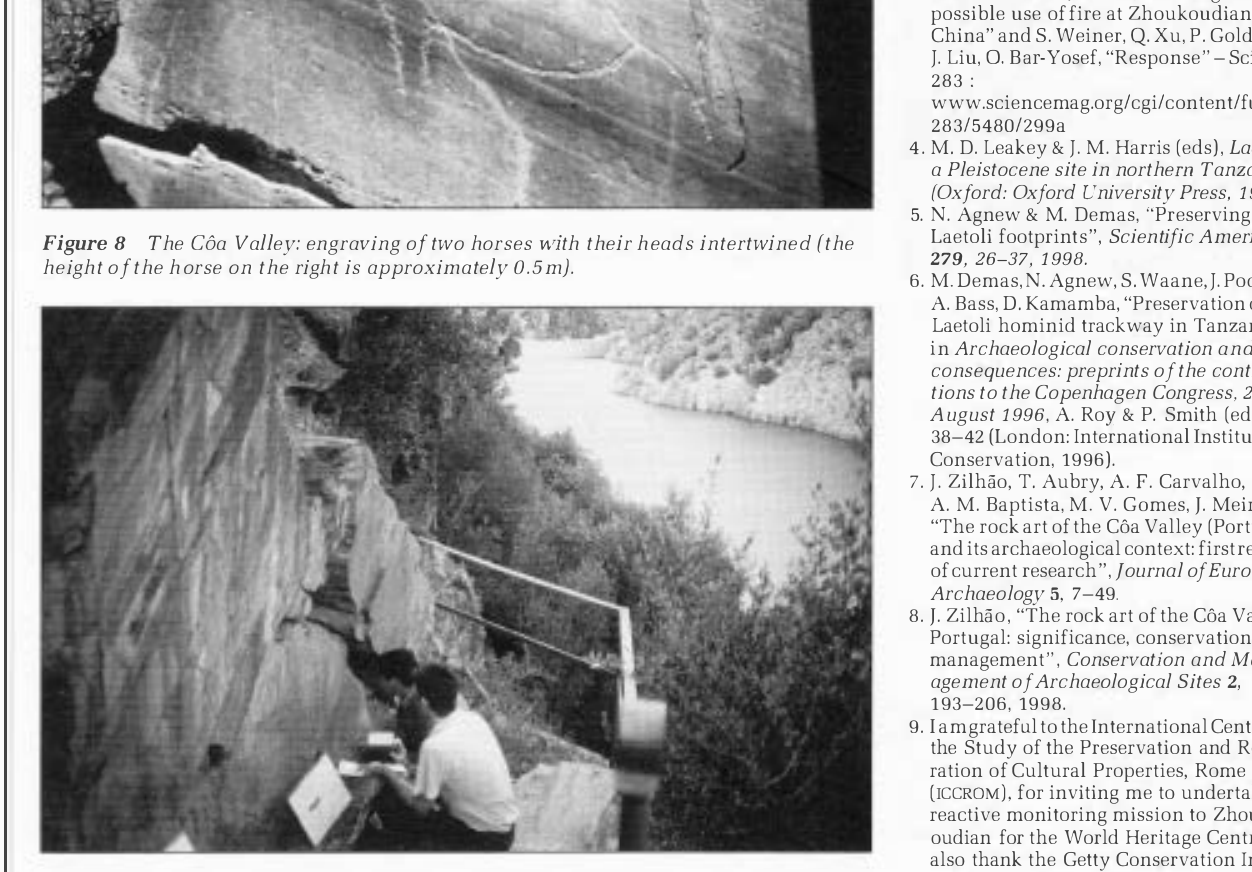
Figure 9 The Coa Valley: guide and visitor inspecting rock art at the Canada do Inferno